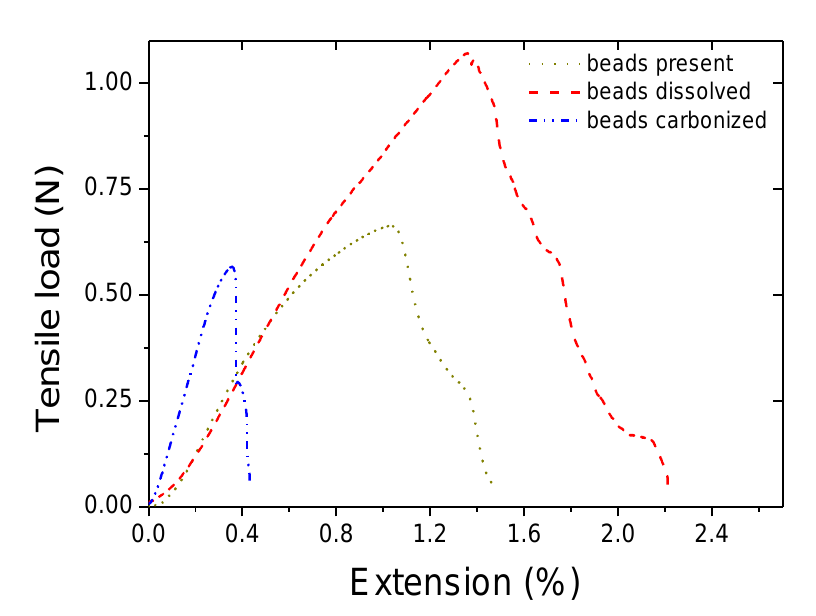
Figure 5. Tensile/extension typical curves for the series of samples.